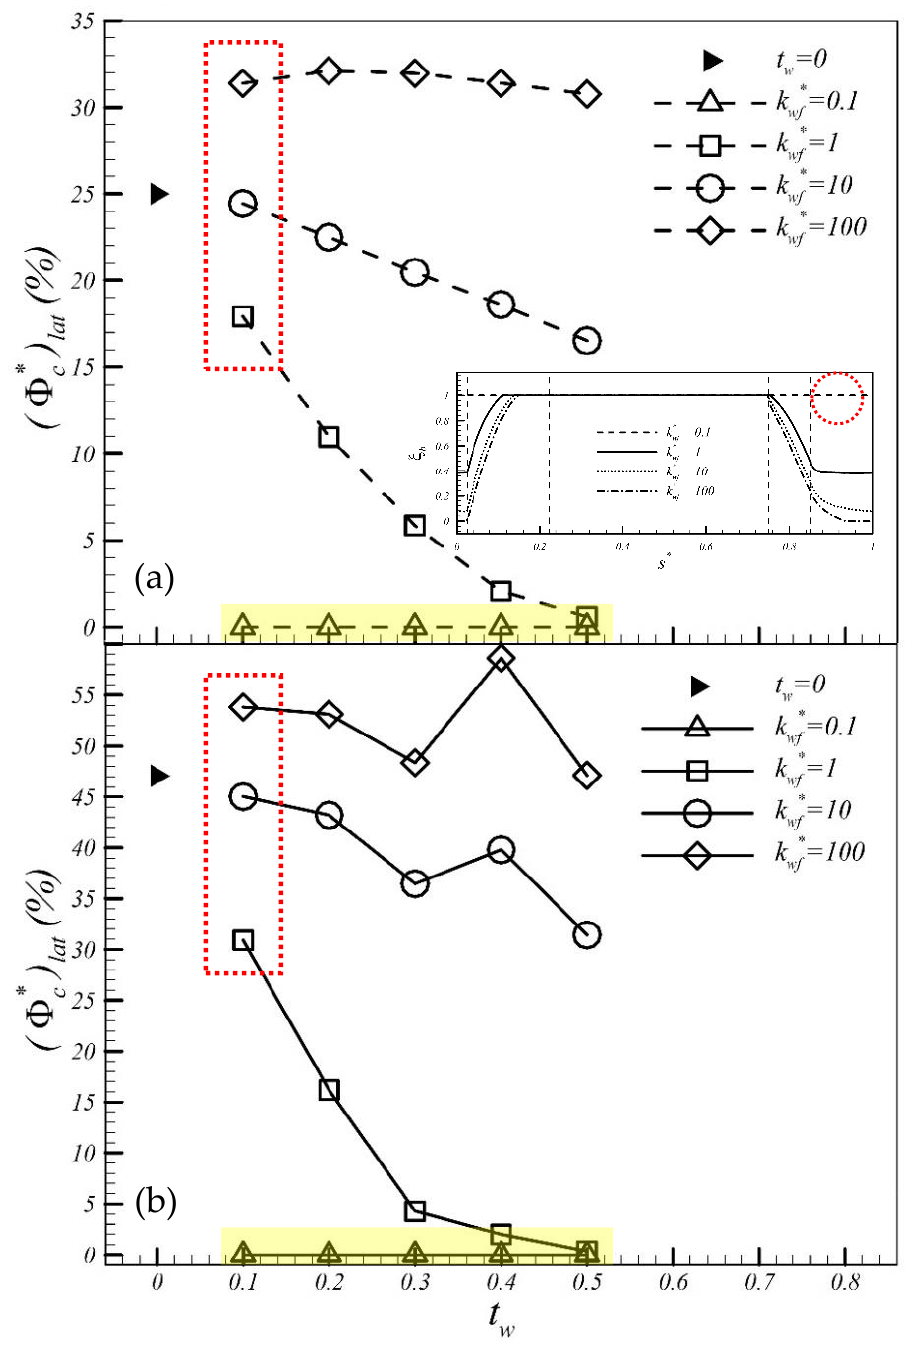
Figure 4. Variation in ( Φ ∗ c ) with t w at various k ∗ (top: ( a ) Ra ∗ = 10 10 and bottom: ( b ) Ra ∗ = 10 11 ) ( AR = 1, 𝑙 ℎ∗ = 0.8, 𝑙 𝑧 = 2, 𝑆𝑏 ∗ = 0.6, 𝑆𝑡𝑒 ∗ = 0.1, and 𝑐 𝑣 = 10%).